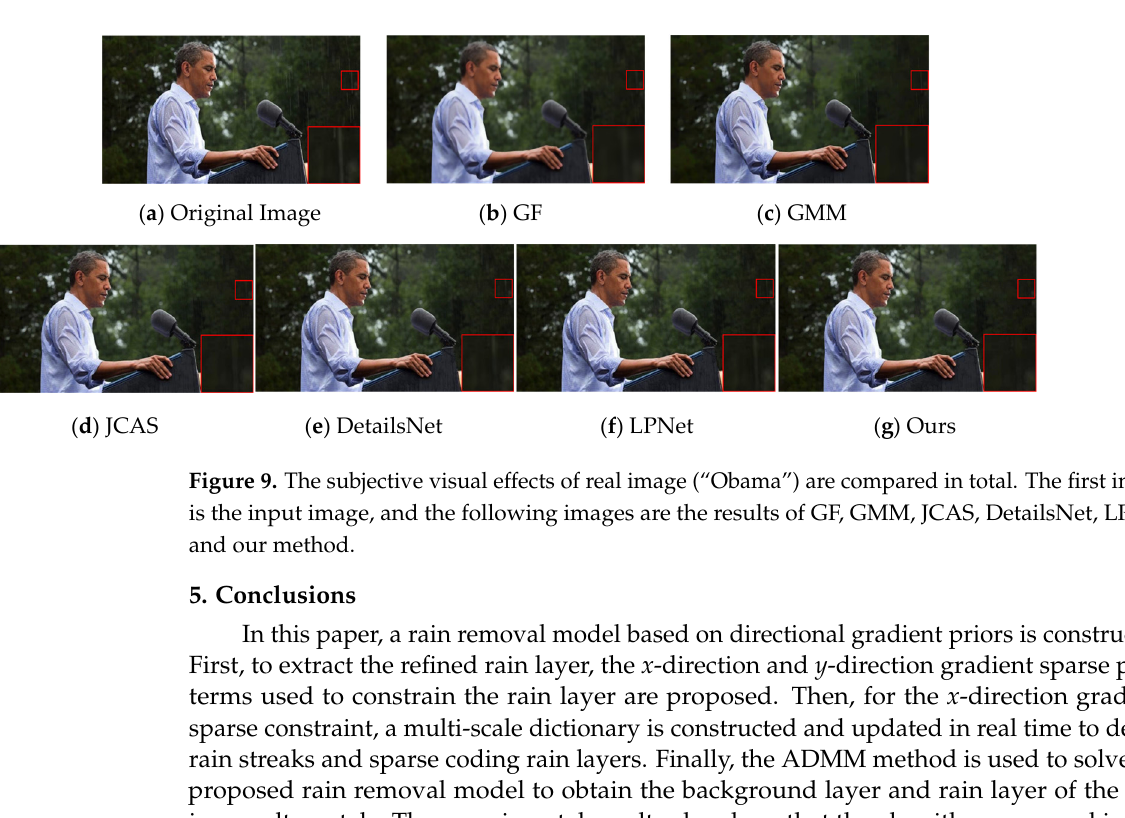
Figure 8. The subjective visual effects of real image are compared in total. The first image is the input image, and the following images are the results of GF, GMM, JCAS, DetailsNet, LPNet and our method.